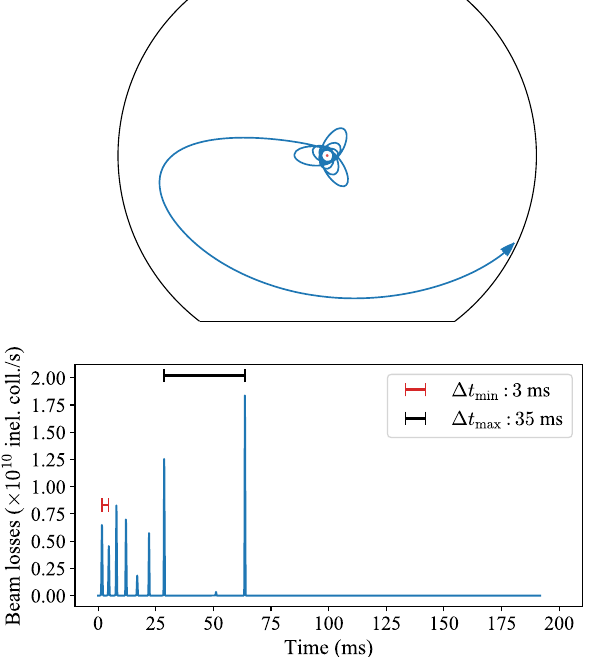
FIG. 10. Example trajectory for a negatively charged dust grain orbiting the LHC beam. With every passage close to the beam, the grain is subject to a positive charging current, and the instanta- neous shape parameter increases. The grain radius is 50 μ m and the initial stiffness is S ¼ − 1 . 18 × 10 − 5 Vm 2 . The simulated inelastic collision rate from the beam-dust interactions is also shown, with peaks in the order of 10 10 inelastic collisions per second, separated by a few ms.